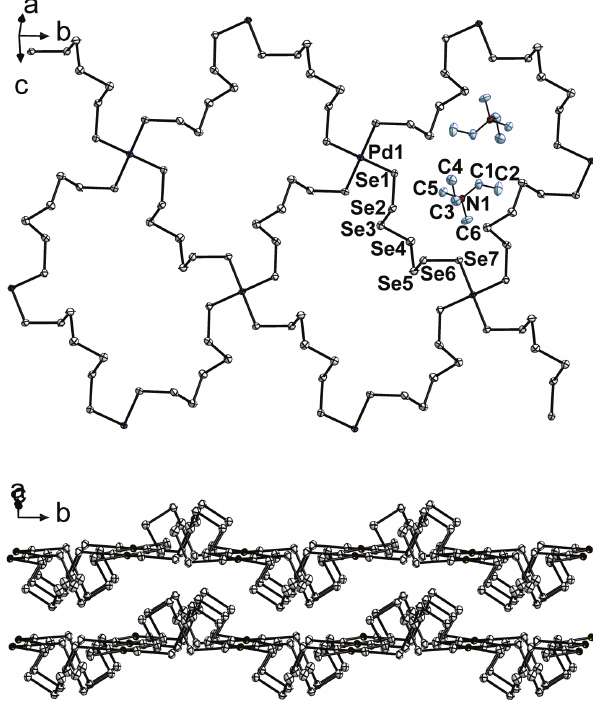
Table 1: Data collection and